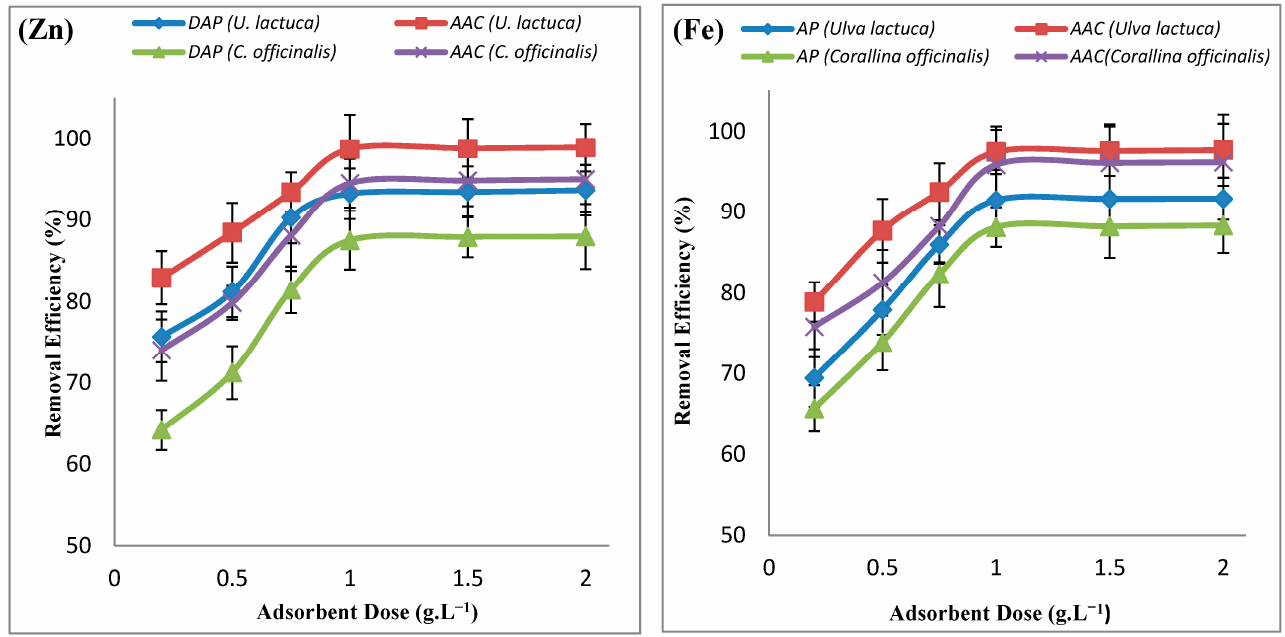
Figure 1. Effect of adsorbant dose of dried algal powder (DAP) and algal activated carbon (AAC) of U. lactuca and C. officinalis on the percentage of removal for Zn +2 and Fe +3 (at pH 5.0 and 50 mg.L − 1 metal-ion concentration and 120 min. contact time). Each data point represents the mean ± SD.